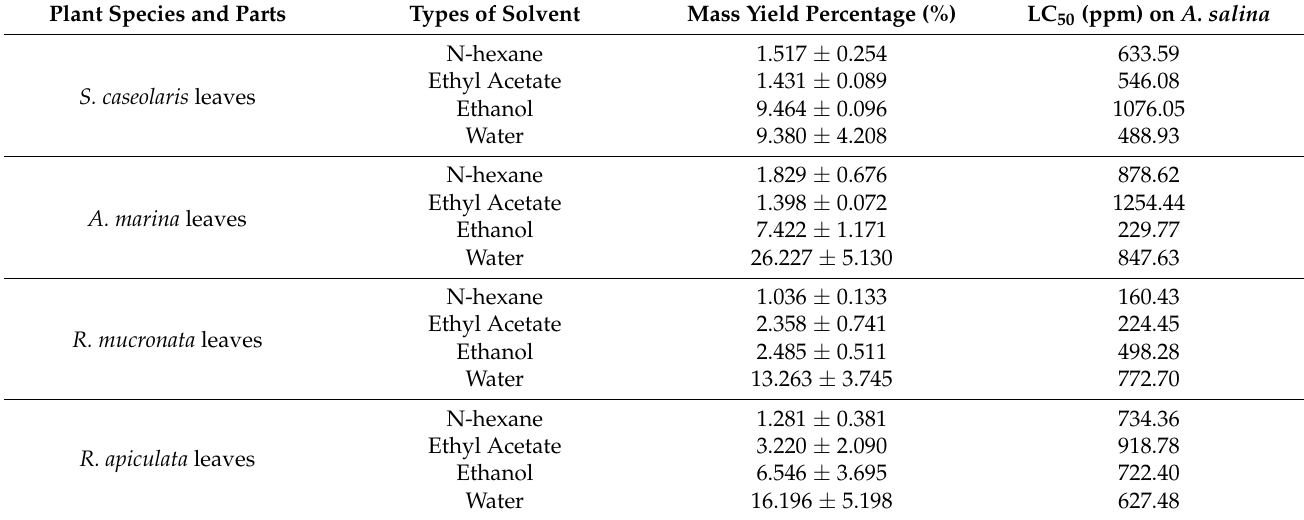
Table 2. Preliminary tests of various local mangrove species leaves extracts for solvent